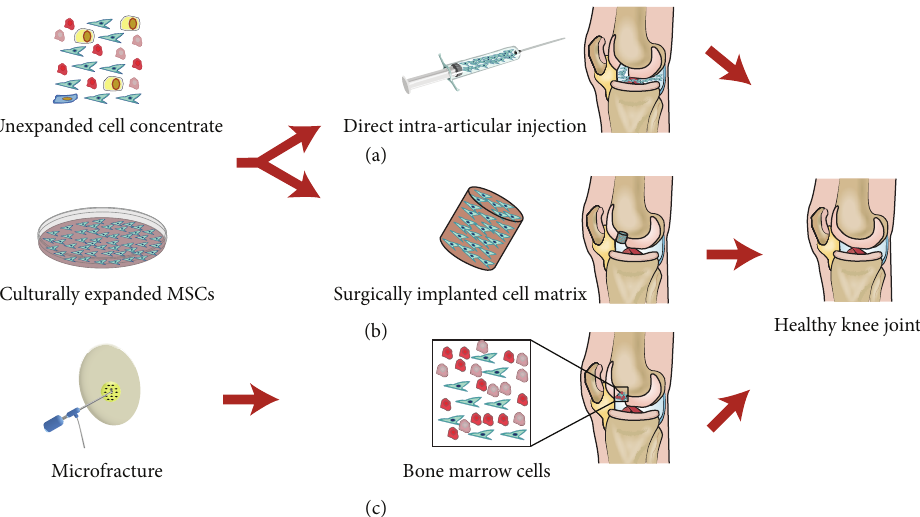
Figure 2: Three different ways in which MSCs can be recruited for articular cartilage repair. (a) Direct intra-articular injections of MSCs in suspensions, (b) surgical implantations of cell sheets or matrixes, and (c) microfracture; drilling into the bone directly recruiting MSCs from the underlying bone